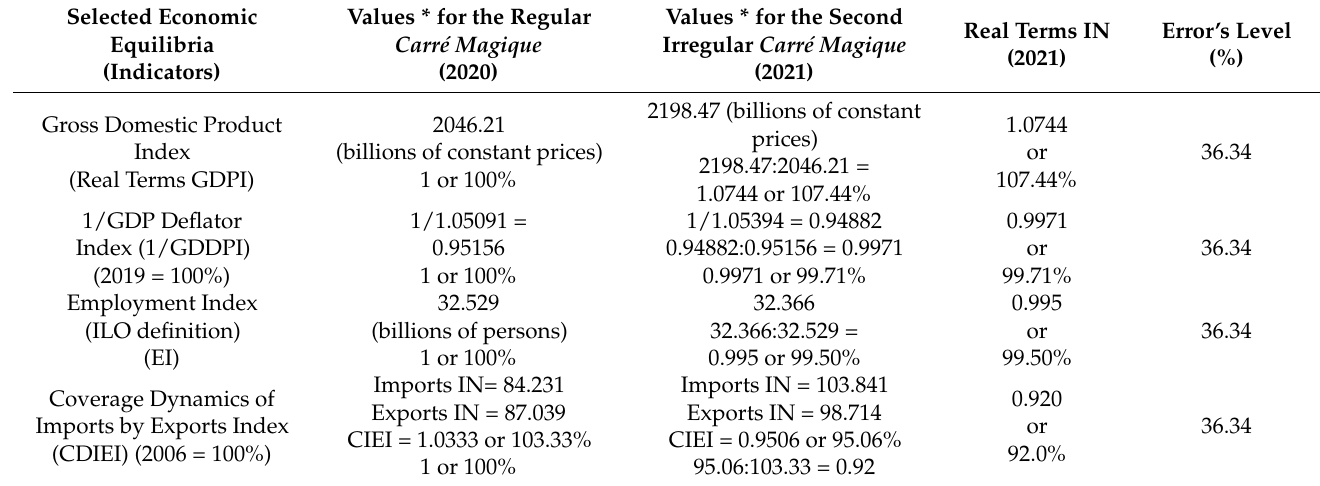
Table 3. A list of values of essential MID indicators adequate in a prospective “carr é magique”, based on UK data, detailed as IN for “ 4-gon ”